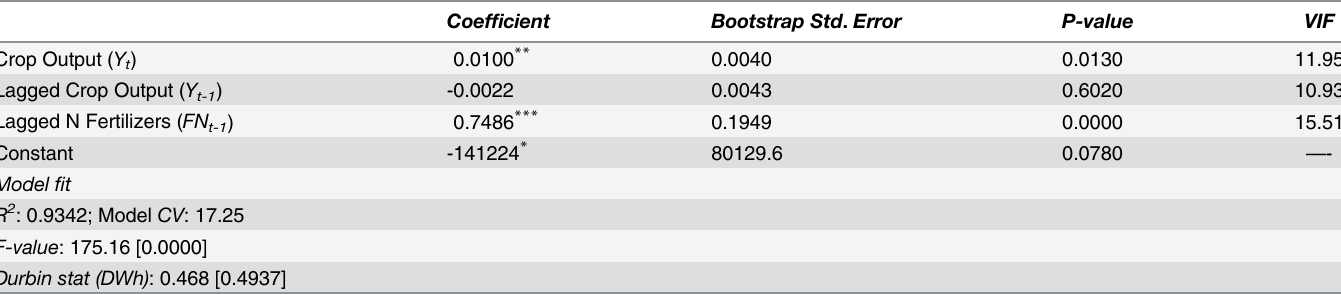
Table 1. Nitrogen fertilizer forecast model estimates for cereal production in